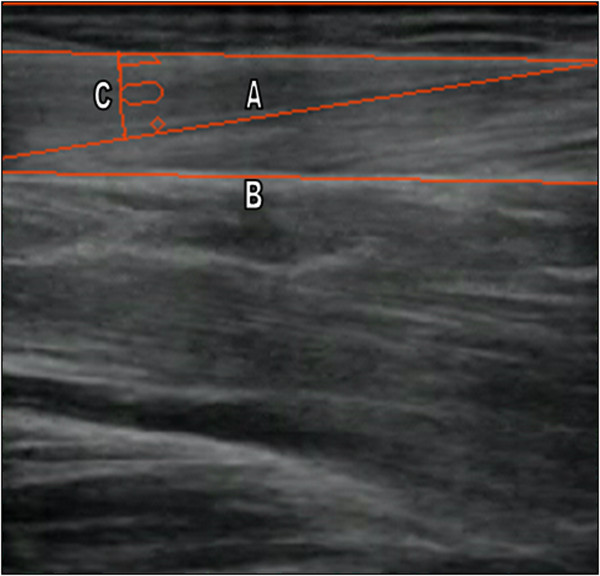
Image showing the measurement of the pennation angle of TA muscle. A. Connective tissue. B. Surface fascicle C. Pennation angle.